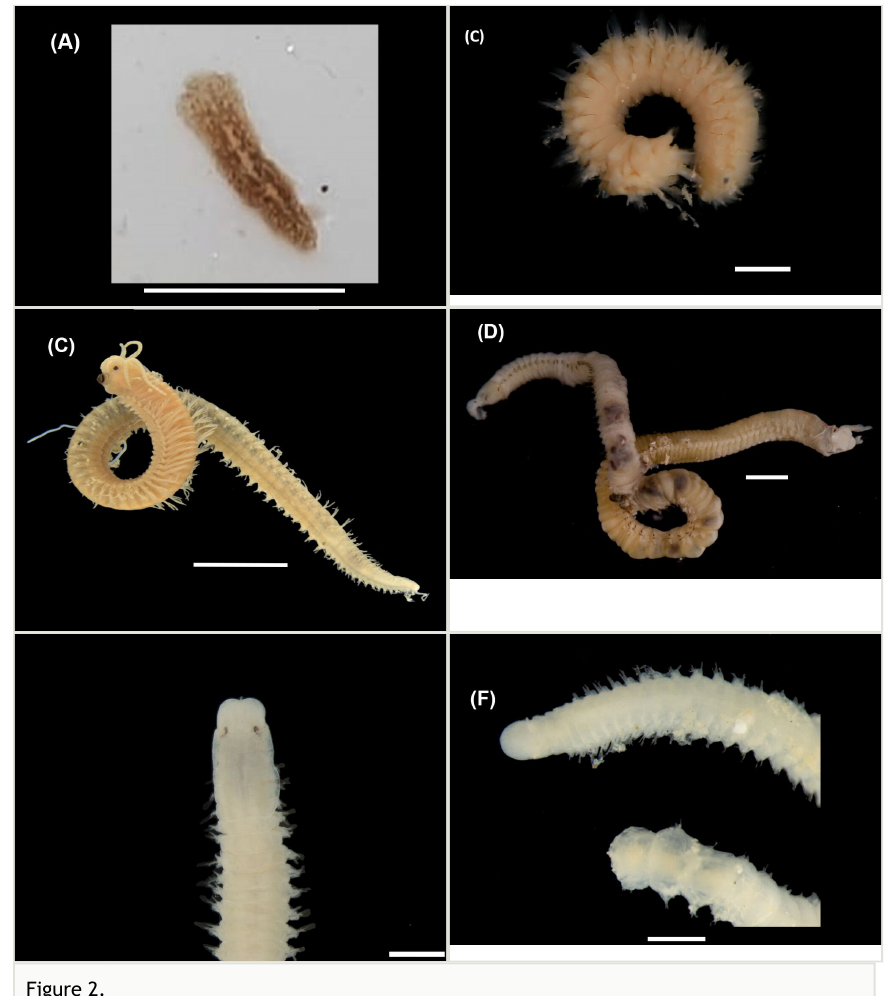
Figure 2. Platyhelminth and annelids polychaetes identified on the beaches from Paraíba coast. Scale bars = 6 mm (A), 2 mm (B-D), 1 mm (E) and 500 µm (F). Photos: (A) by Costa, D.A.; (B,C,E and F) by Prata, J.; (D) by Freitas,